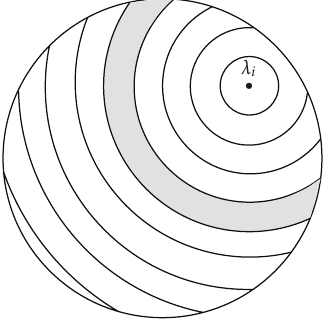
Figure 2: Level sets of the hop-distance function corresponding to the landmark λ i . The shaded area represents a sample level set, which is the result of the intersection of the environment with an annulus centered at λ i and of radii r 1 , r 2 di ff ering by r